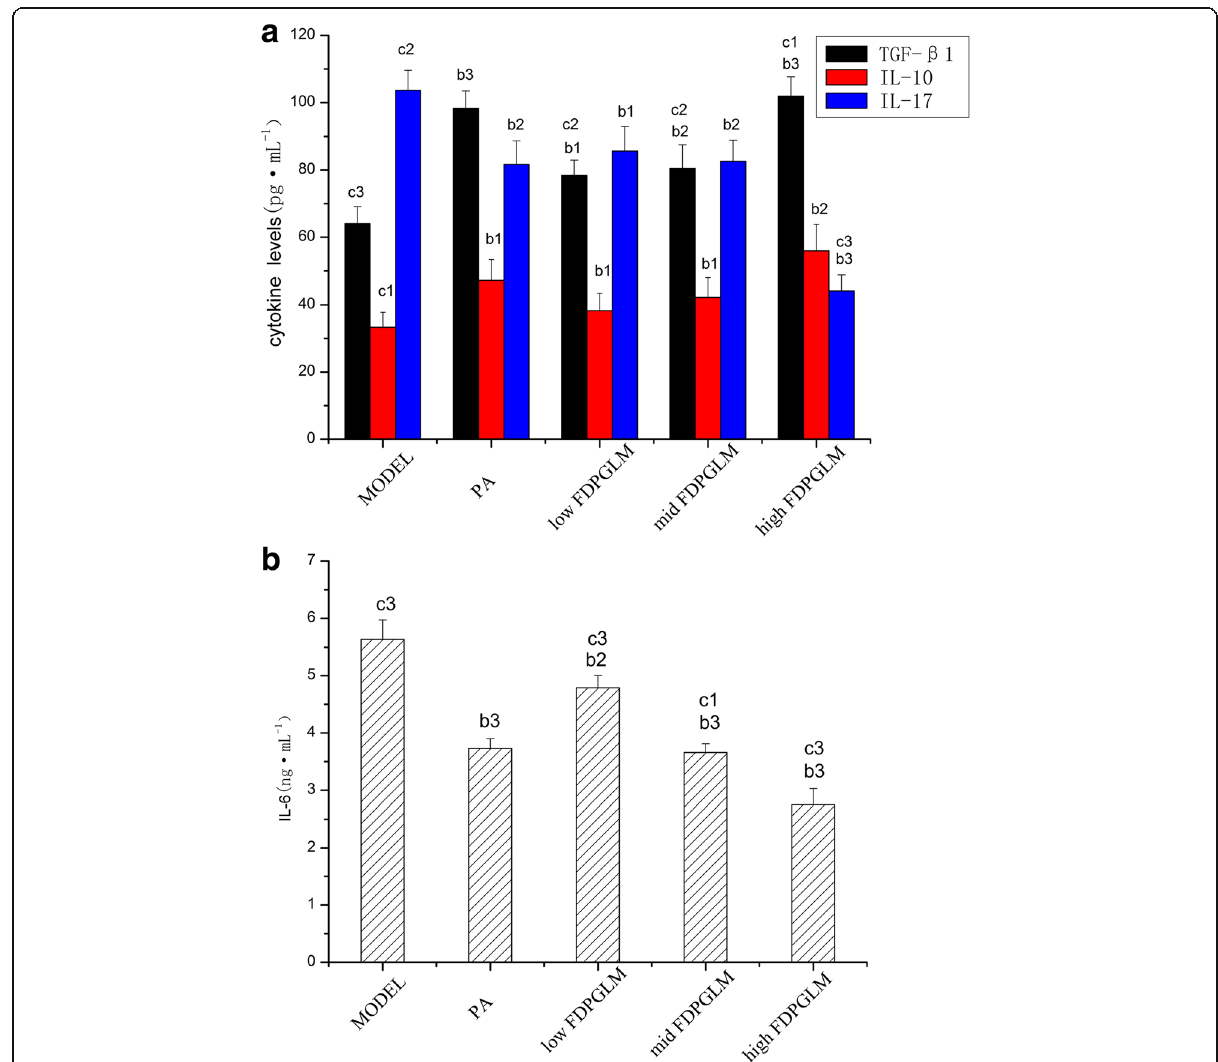
Fig. 2 Effect of FDPGLM on serum levels of CK associated with th17 cells and Tregs. ① b, each group compared to the model group; c, each group compared to the positive drug group. ② b1: P > 0.05, b2: P < 0.05, b3: P < 0.01; c1: P > 0.05, c2: P < 0.05, c3: P < 0.01. ③ Statistical symbols and their meanings in following figures or tables are the same as this